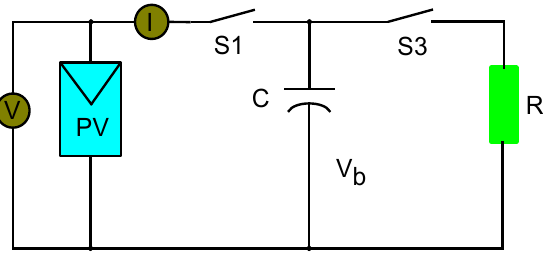
Figure 9. Schematic of a simpler capacitive load tracer. Source [11] , own elaboration.